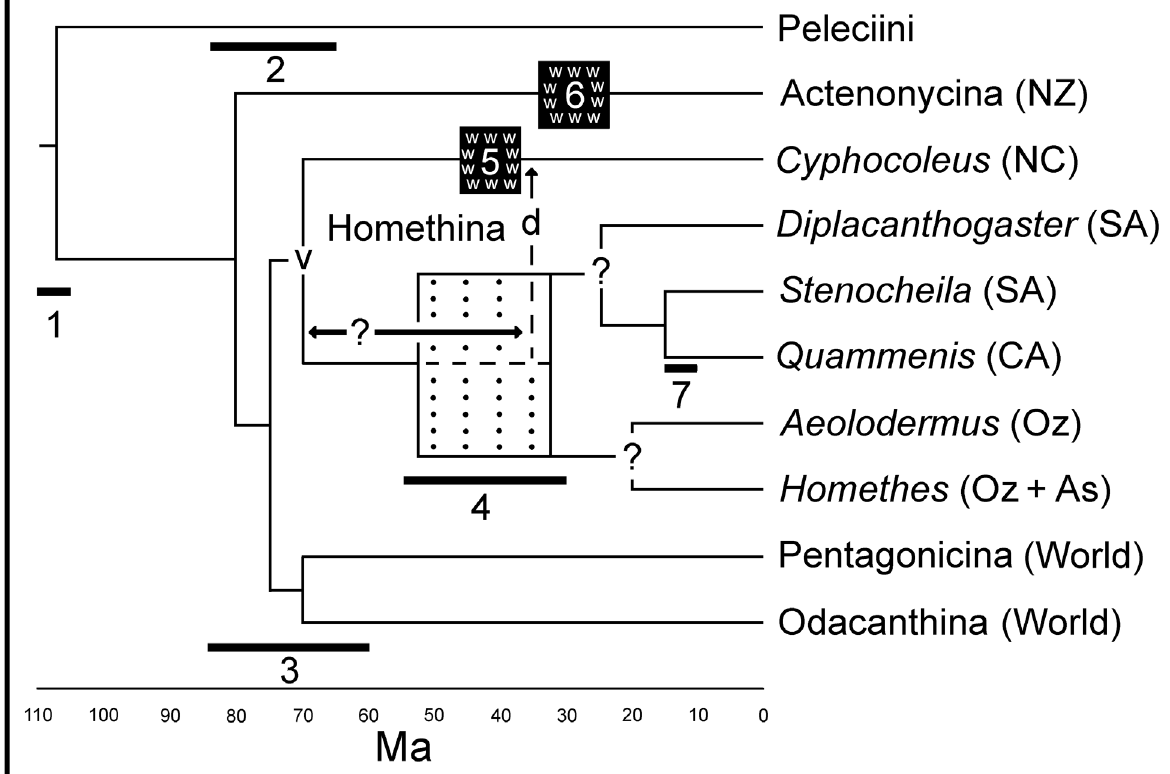
Figure 166. Diversification history of odacanthine subtribes and generic-level taxa within Homethina placed in temporal context defined by major geological events and molecular dating estimates (Ober and Heider 2010). Major events and dating estimates con - straining historical relationships of the represented taxa include: 1 , 100–105 Ma, estimated age of origin of Odacanthini relative to its proposed adelphotaxon Peleciini (Ober and Maddison 2008, Ober and Heider 2010); 2 , 84–65 Ma, estimated divergence times of lineages within Odacanthini, represented in this study by Actenonycina, Pentagonicina, and Odacanthina (Ober and Heider 2010); 3 , 84–61Ma, rifting of Zealandia, including New Caledonia and New Zealand, from Australia (McLoughlin 2001, Ladiges and Can- trill 2007); 4 , 50–30 Ma, extended rifting and increased isolation of Australia and South America from Antarctica due to opening of the Tasman Sea at 50 Ma (Woodburne and Case 1996, Sanmartín and Ronquist 2004), development of the Australo-Antarctic Gulf at 35–32 Ma (McLoughlin 2001, Lawver and Gahagan 2003), and opening of Drake Passage at 34–30 Ma (Livermore et al. 2005); 5 , 46–37 Ma, hypothesized submergence of New Caledonia (Grandcolas et al. 2008); 6 , 34–23 Ma, hypothesized Oligocene drowning of New Zealand (Campbell and Hutching 2007); 7 , 15–10 Ma, closing of Panamanian Isthmus establishing subaerial contact between South and Central America (Montes et al. 2015). Time of divergence of Cyphocoleus unconstrained due to lack of molecular-dating data. Under vicariance hypothesis (v), the ancestor of Cyphocoleus was emplaced on Zealandia in Late Cretaceous (event 3 ). Under dispersal scenario (d with dashed line), Cyphocoleus dispersal to New Caledonia is constrained at the lower bound by reemergence of Grande Terre after putative Oligocene submergence (event 5 ), and at upper bound by amphiantarctic vicariance at Austral-Antarctic Gulf that isolated Antarctica from Australia (event 4